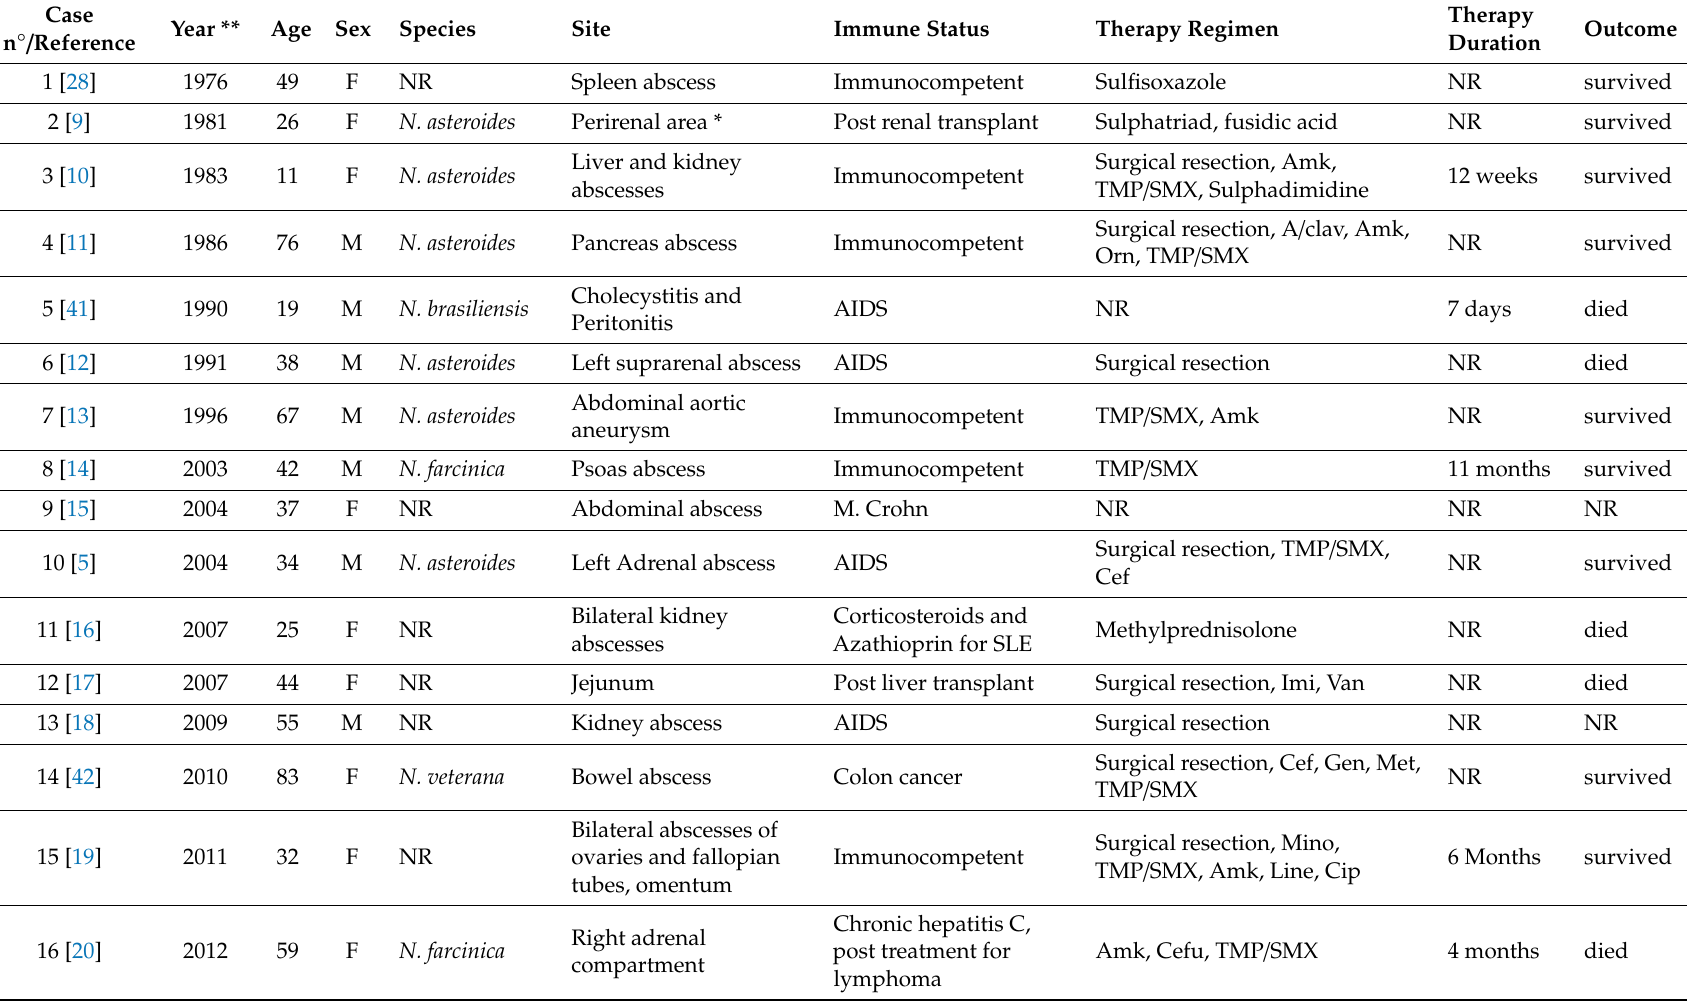
Table 2. Previously published cases of isolated abdominal / retroperitoneal